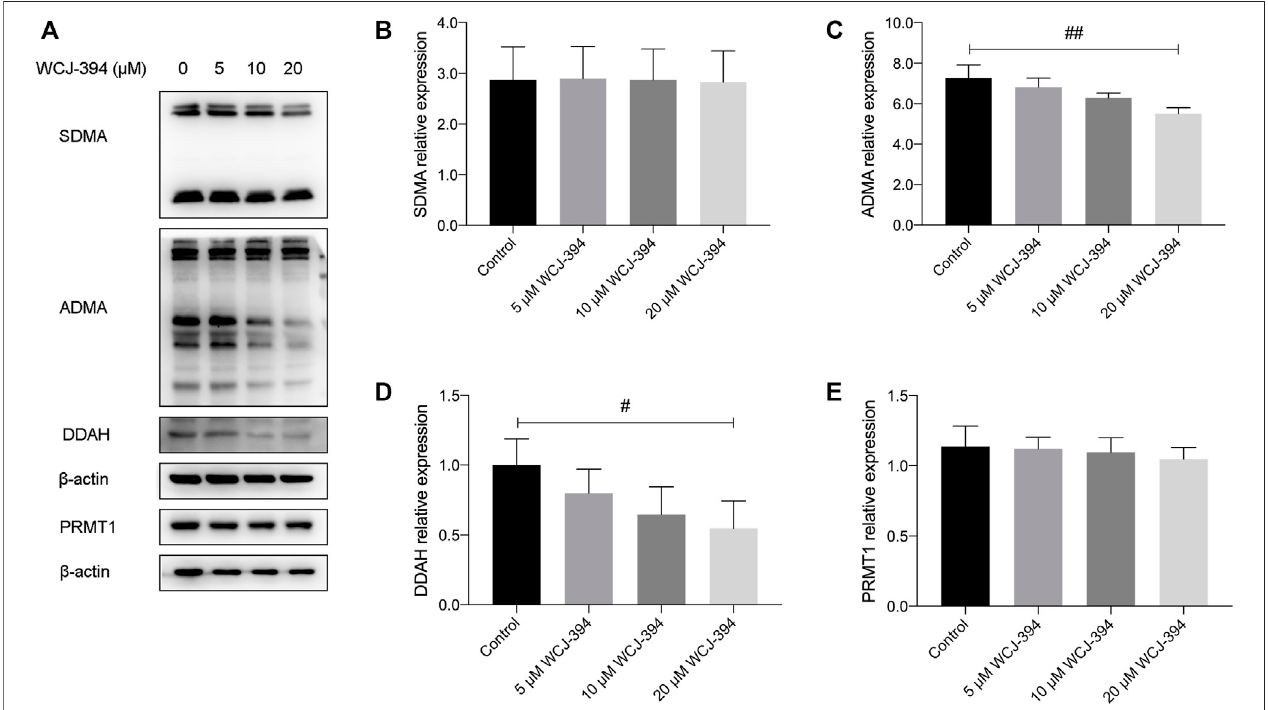
FIGURE 2 | Effect of WCJ-394 on PRMT-related proteins in A549 cells. (A) Western blot result of symmetrical dimethylarginine (SDMA), asymmetrical dimethylarginine (ADMA), dimethylarginine dimethylaminohydrolase (DDAH), and protein arginine methyltransferase 1 (PRMT1) proteins in A549 cells treated with WCJ- 394 (5, 10, 20 μ M). (B – E) Expression levels of SDMA, ADMA, DDAH, and PRMT1 relative to the internal control β -actin. # p < 0.05, ## p < 0.01 vs. the control group.